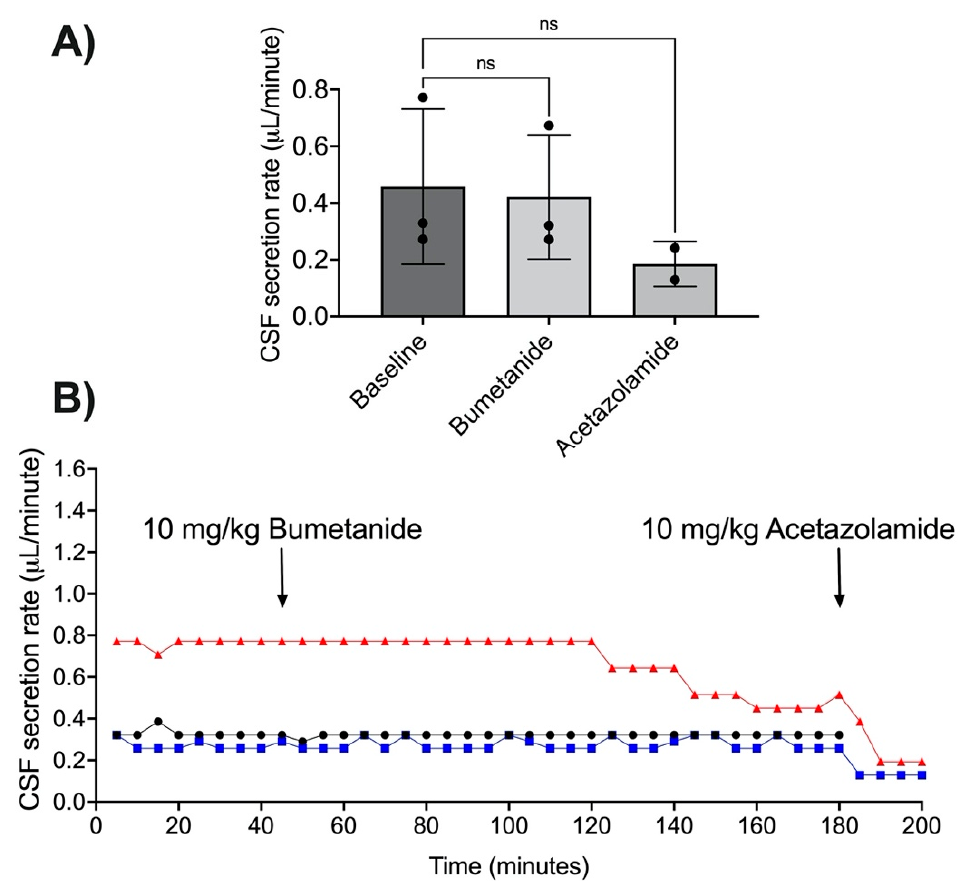
Figure 2. Effects of bumetanide on cerebrospinal fluid (CSF) secretion. ( A ) CSF secretion rate (mean ± SD; μ L/min) for all animals at baseline, after administration of bumetanide, and after administration of acetazolamide. Points represent individual animals. ( B ) Individual CSF secretion rate plots over time in response to bumetanide and acetazolamide. Symbols and colours are distinct for each animal. ns = no significant difference, Student’s t -test compared with baseline.